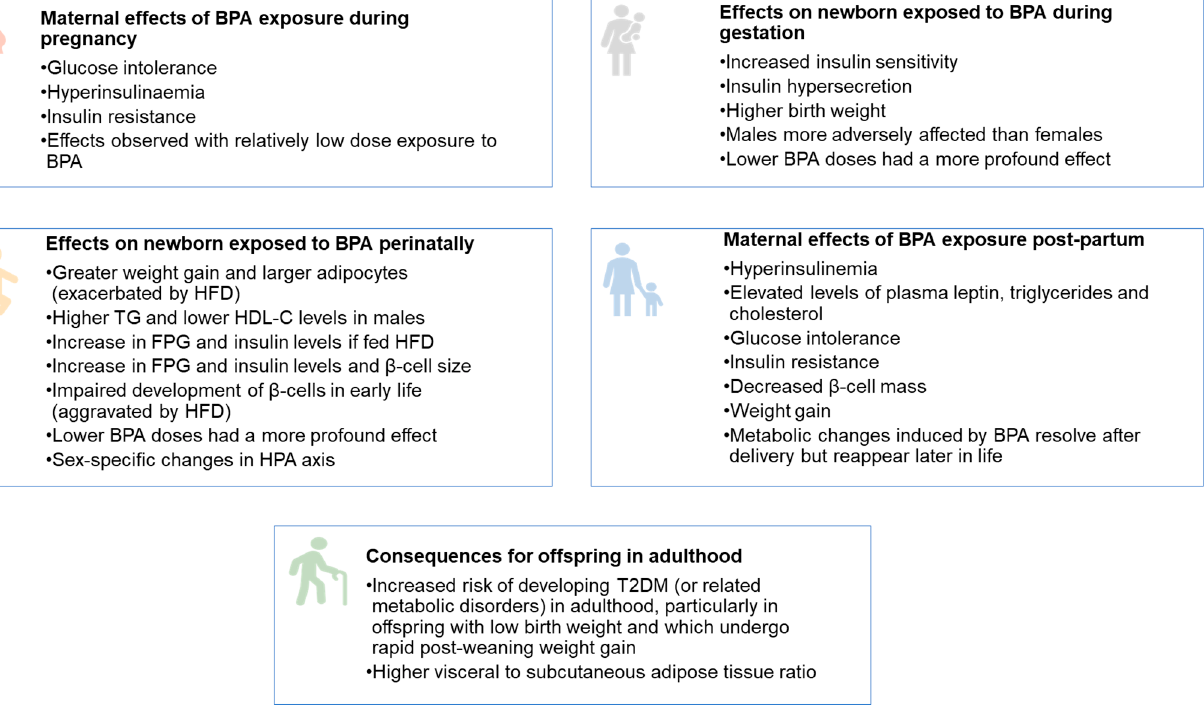
Figure 1. Overview of the adverse metabolic effects of BPA at the foetal, neonatal, and adult stages. HFD—high fat diet. TG—triglycerides. HDL-C—high density lipoprotein cholesterol.